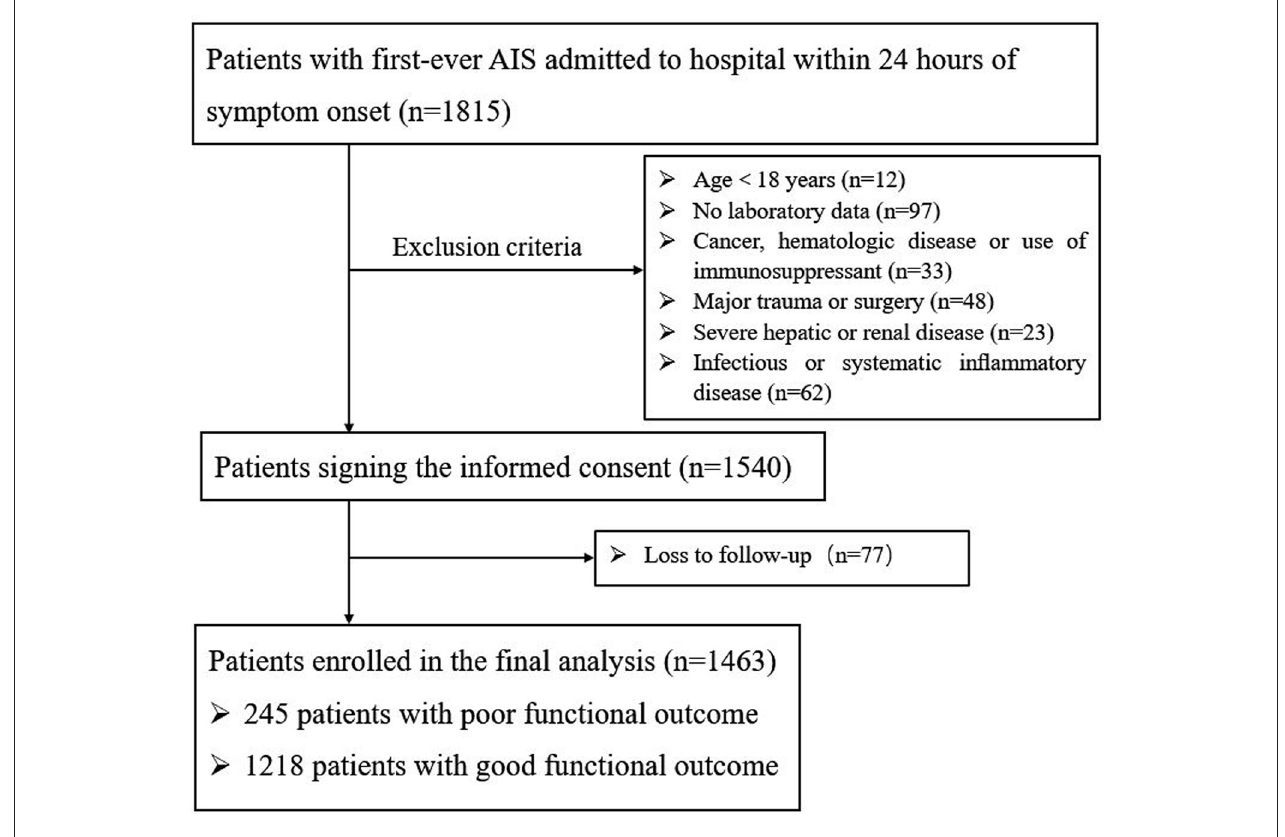
FIGURE 1 | Patient flowchart of the